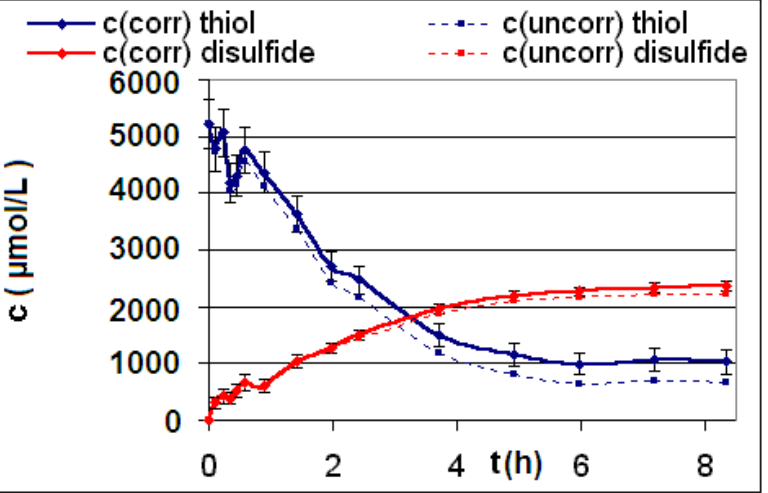
( t ) /c ( t ). corr uncorr